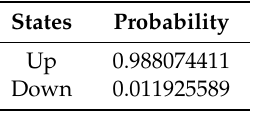
Table 4. Two States model of string PV system components.